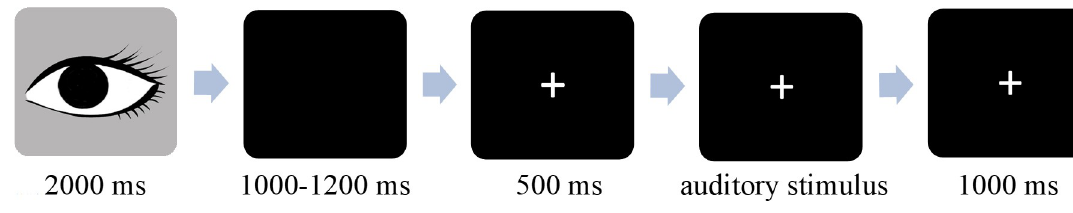
Fig 3. Schematic diagram of the trial